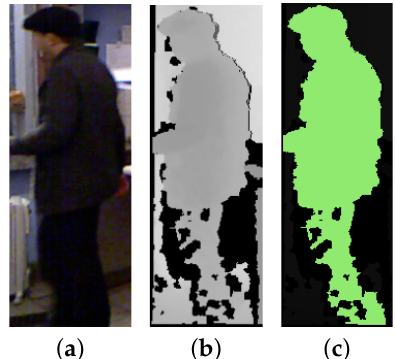
Figure 14. Extract pedestrian contours. ( a ) shows the area where the pedestrian is located in the colour image, ( b ) shows the area where the pedestrian is located in the depth image, and ( c ) shows the effect map after the depth map-based flood